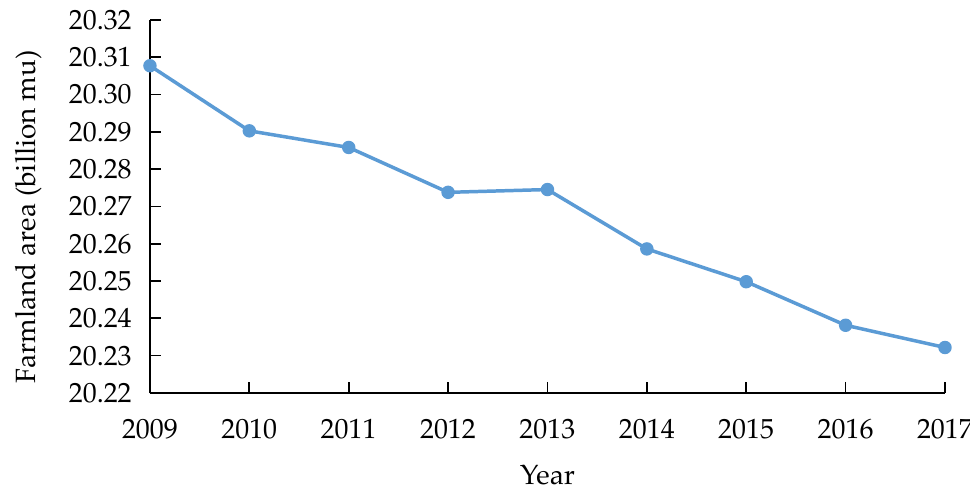
Figure 2. Changes in China’s farmland area from 2009 to 2017 [51].